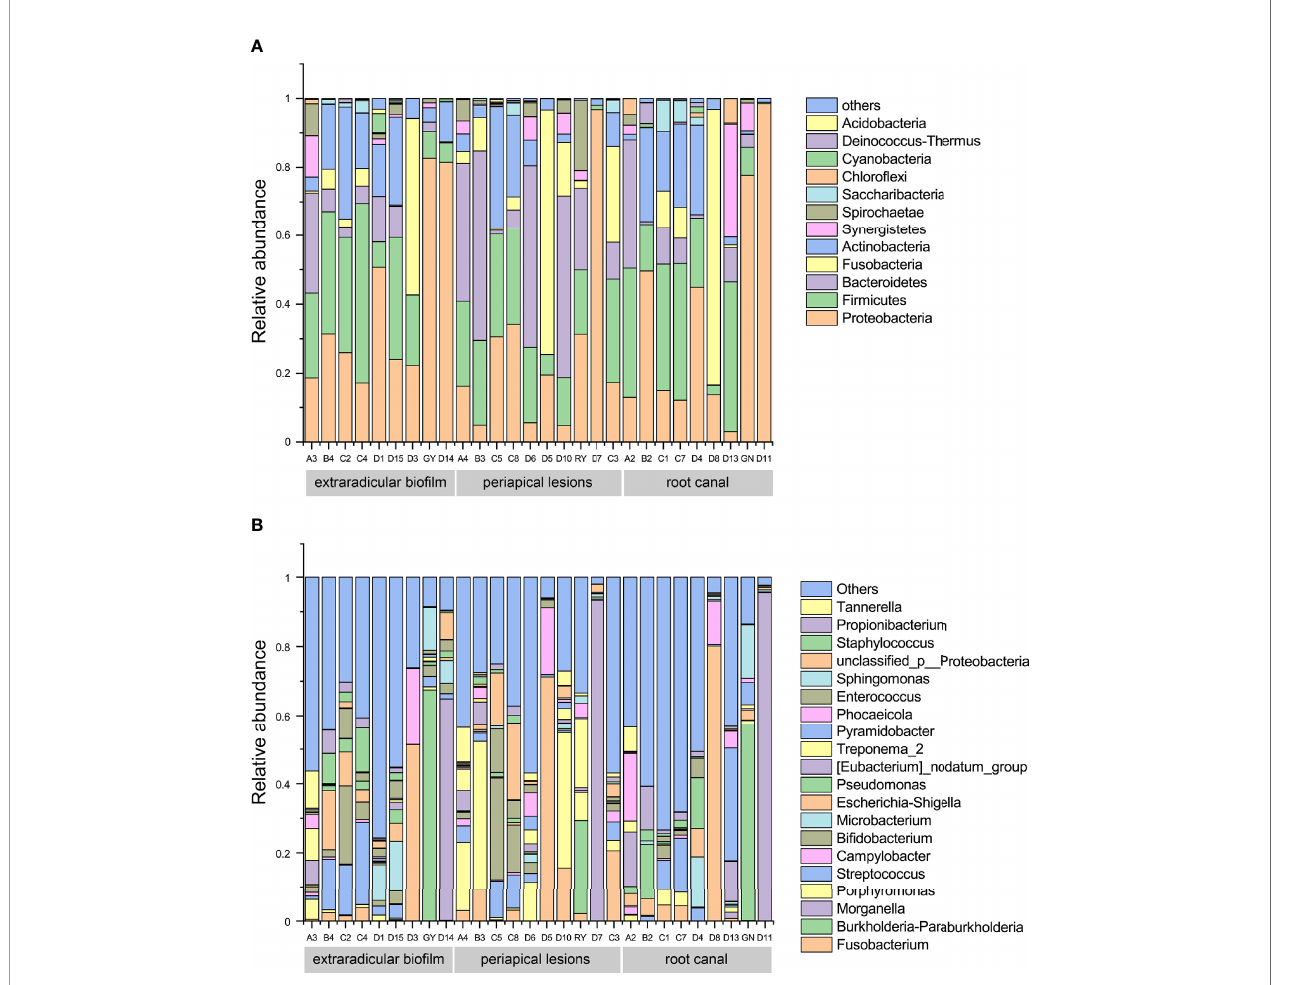
FIGURE 3 | Bacterial compositions of samples from the root canal, extraradicular bio fi lm, and periapical lesions. (A) bacterial compositions at the phylum level; (B) bacterial compositions at the genus